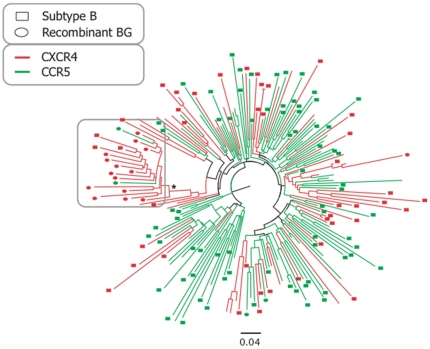
Phylogenetic tree for the C3-V3 genomic region of the recombinant BG sequences, sequences downloaded from the Los Alamos database and from Portuguese patients, showing the significant clustering of BG sequences and associated CXCR4 usage.Sequences are labeled according to subtype and coreceptor usage, Sequences were either subtype G in pol and subtype B in env (circles), subtype B both in pol and in env (squares). If the sequences were subtype B only in env (no information available for pol), no label was added. Sequences colored green use CCR5 only, while sequences colored red can use CXCR4. Asterisk indicates significant support for the cluster (LRT >0.95). Tree was built as described in the methods section.